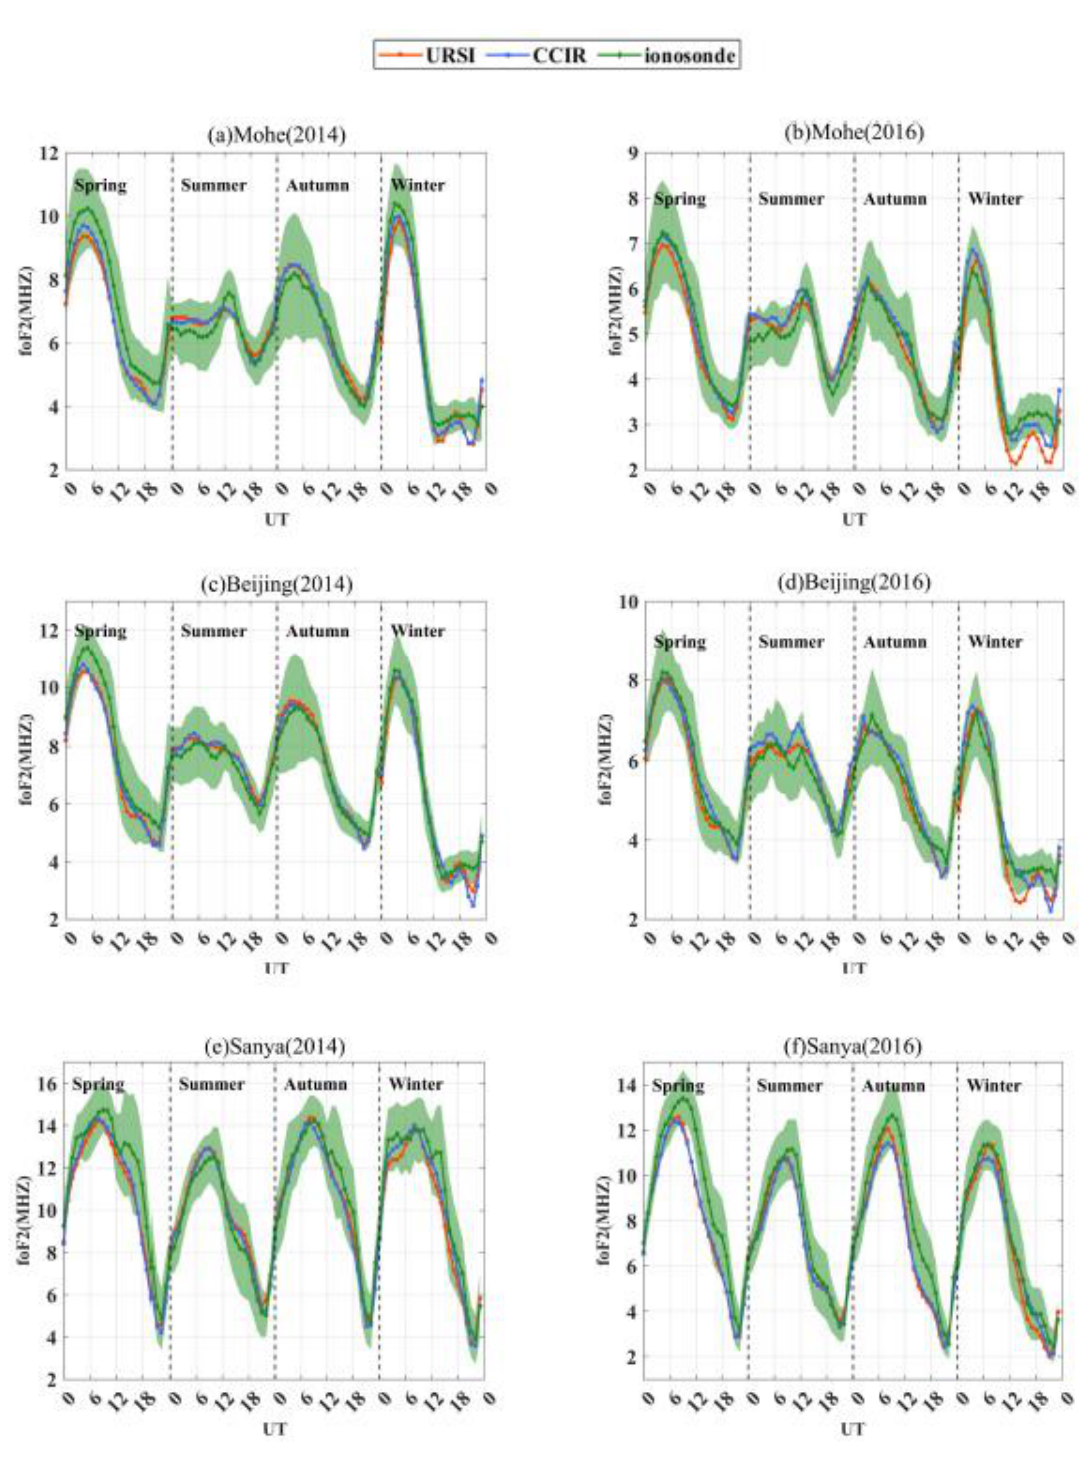
Figure 4. Diurnal variation of foF2 from ionosonde and two IRI-2016 options (CCIR and URSI) in the four different seasons for the years 2014 and 2016 at Mohe, Beijing and Sanya over China. ( a ) Mohe(2014), ( b ) Mohe(2016), ( c ) Beijing(2014), ( d ) Beijing(2016), ( e ) Sanya(2014), ( f ) Sanya(2016). Figures 5 and 6 present the diurnal RMS/MARE variation of IRI-2016 URSI and CCIR of the predicted foF2 compared with the foF2 parameter measured in Mohe, Beijing and Sanya in the four different seasons for the years 2014 and 2016, respectively. Tables 3 and 4 show the daily averaged RMS/MARE values of IRI-2016 URSI and CCIR predicted foF2